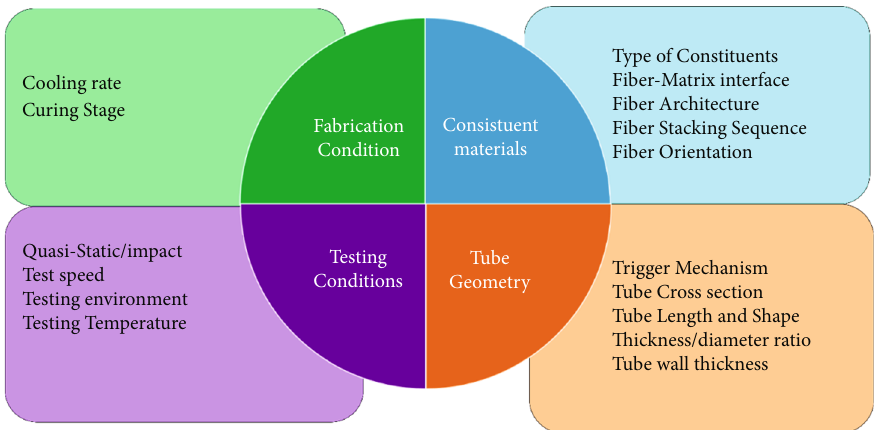
Figure 8: Factors in fl uencing crashworthiness parameters of